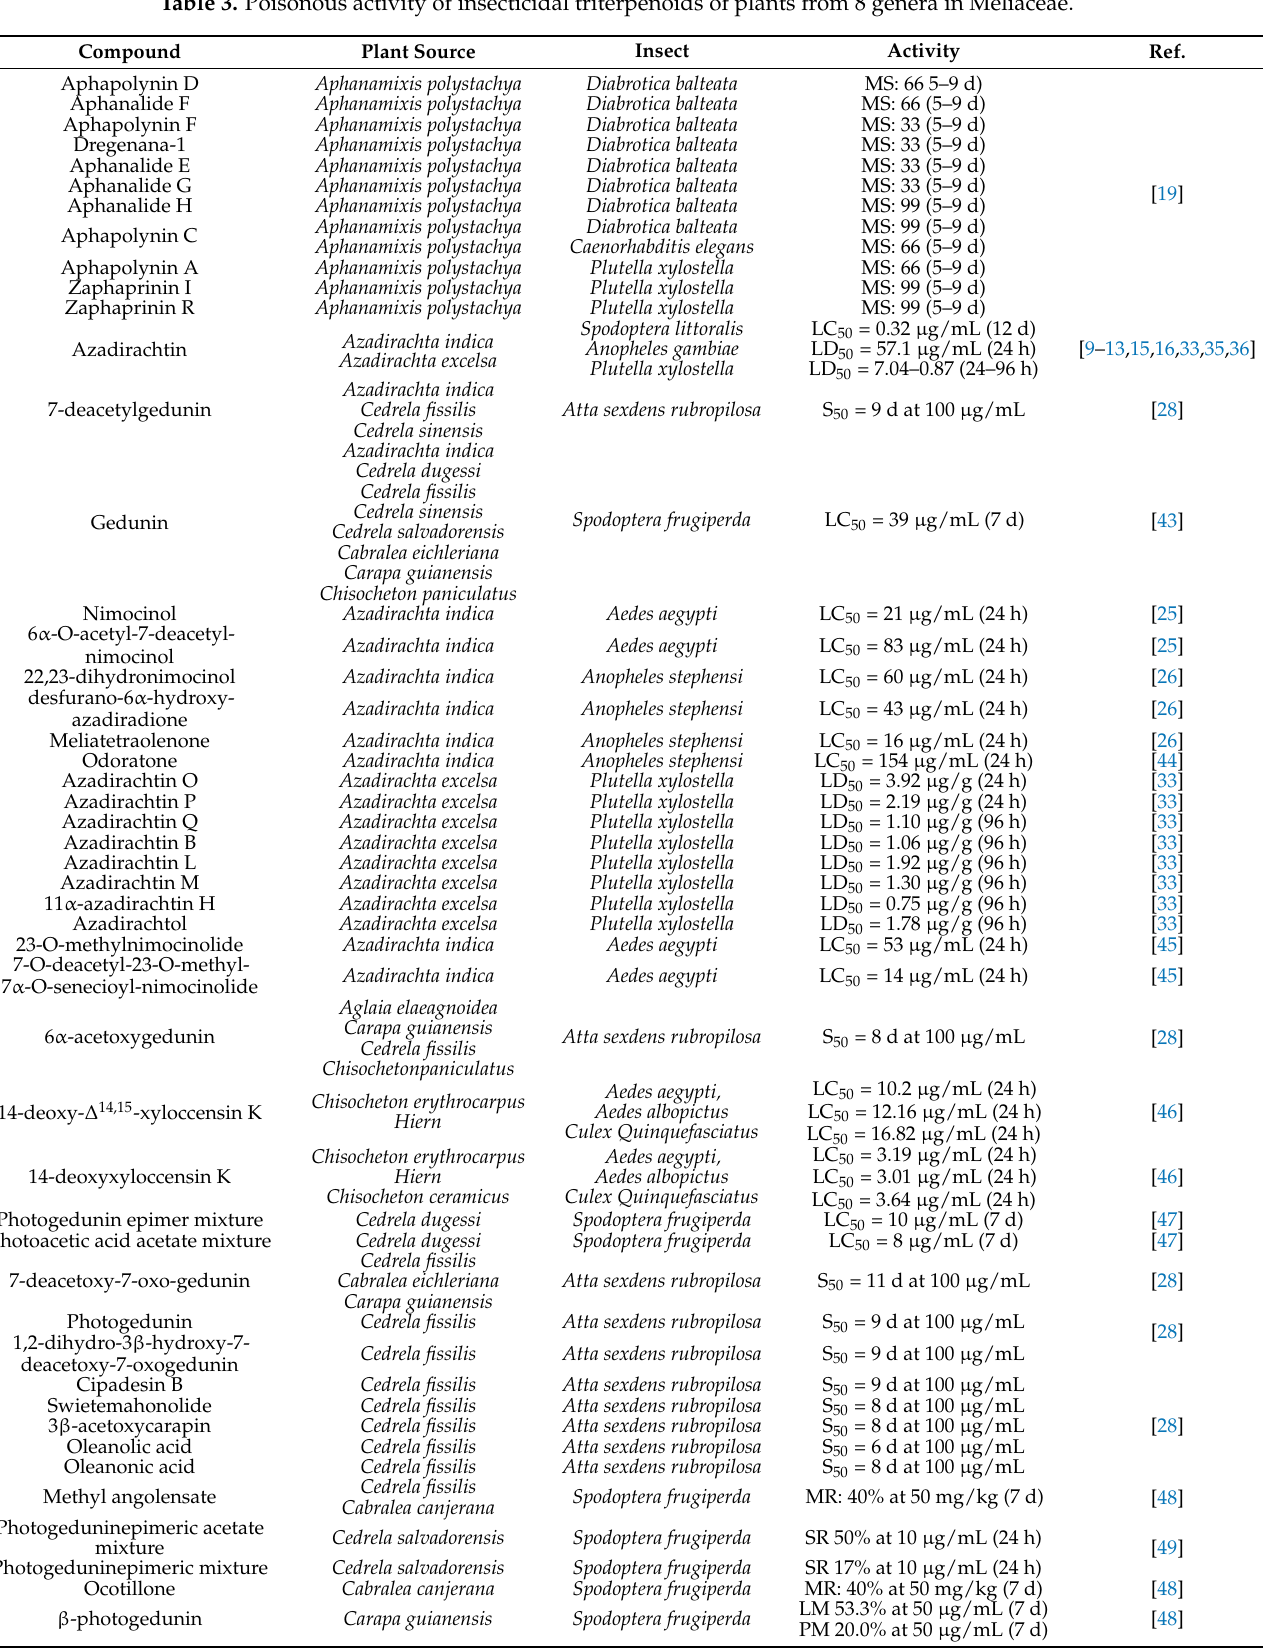
Table 3. Poisonous activity of insecticidal triterpenoids of plants from 8 genera in Meliaceae.